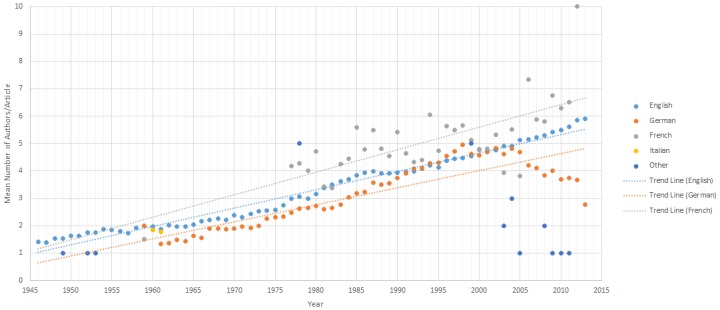
Average Authorship from 1946–2013 by Publication Language.* Trendline for Italian language journals was not included due to data being available for only 2 publication years.